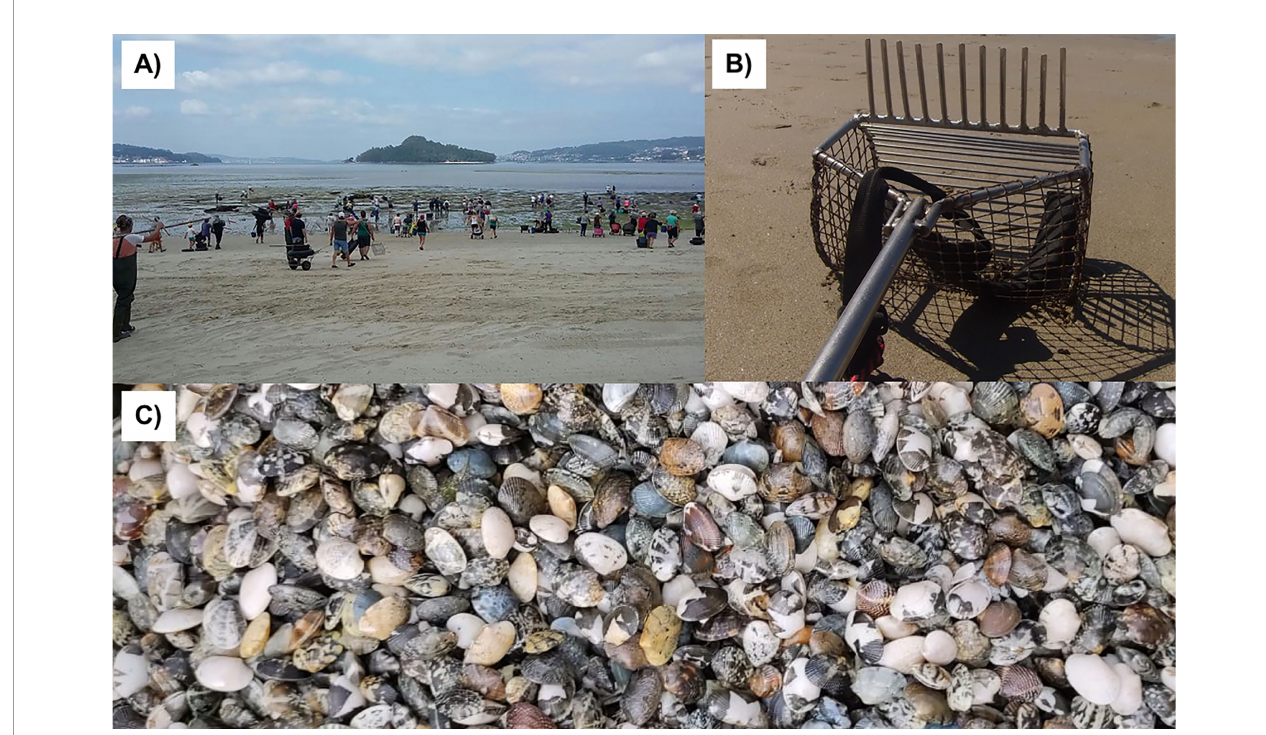
FIGURE 2 | Images of (A) women harvesting on foot in shell fi sh beds located in the Galician “ rias ” , (B) the rake-like fi shing gear called “ raño ” , and (C) the most common shell fi sh species manila clam, cockle, grooved carpet shell, and pullet carpet